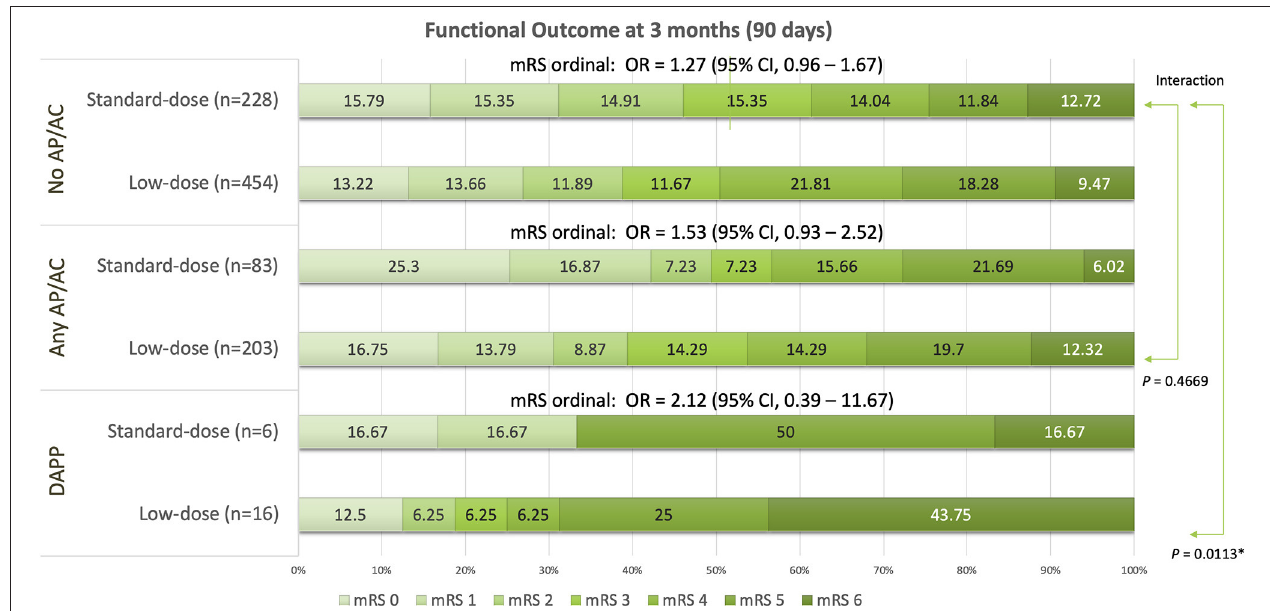
FIGURE 1 | Global functional outcomes at 90 days for groups of patients having pre-treatment without any antiplatelets or anticoagulants (no AP/AC), with any antiplatelets or anticoagulant (any AP/AC), and with dual antiplatelet (DAPP). * P <